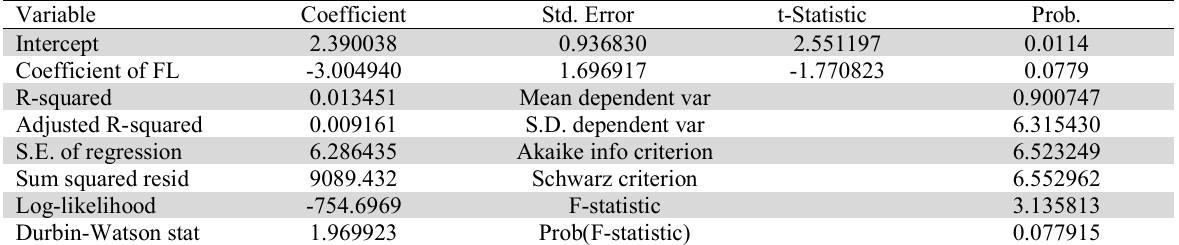
ROS model (Dependent variable: ROS, Observations: 357)